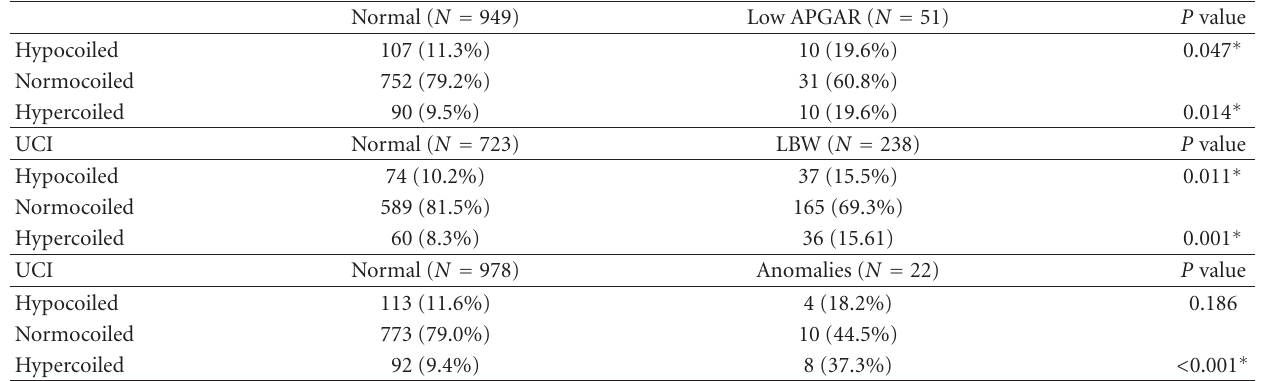
Table 5: Distribution frequencies of the three groups according to the neonatal factors.